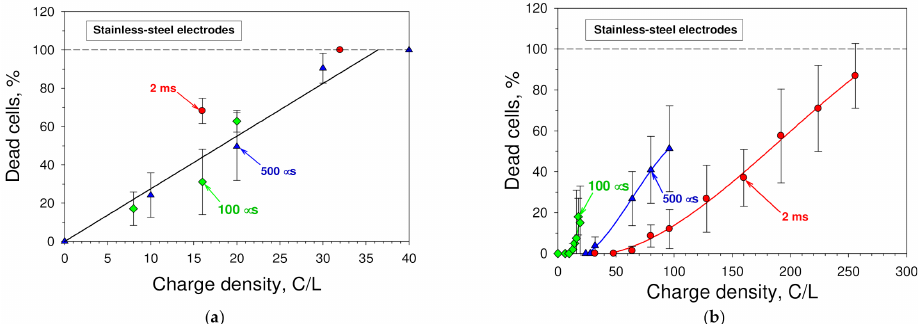
Figure 3. Killing of cells by the electric pulse-treated cell culture medium and the pulse of an electric field. ( a ) Dependence of the fraction of intact MH-22A cells, which died in the medium treated with a square-wave electric pulse, on the charge that has flown through the cell suspension per unit volume of the medium, obtained from the data shown in Figure 2. ( b ) Dependence of the fraction of MH-22A cells killed by a square-wave electric pulse on the charge that has flown through the cell suspension per unit volume of the medium, obtained from the data presented in Figure 1. In both cases, experiments were carried out with mouse hepatoma MH-22A cells, and their viability was determined by a colony-forming assay after the incubation at 37 ◦ C for 9–10